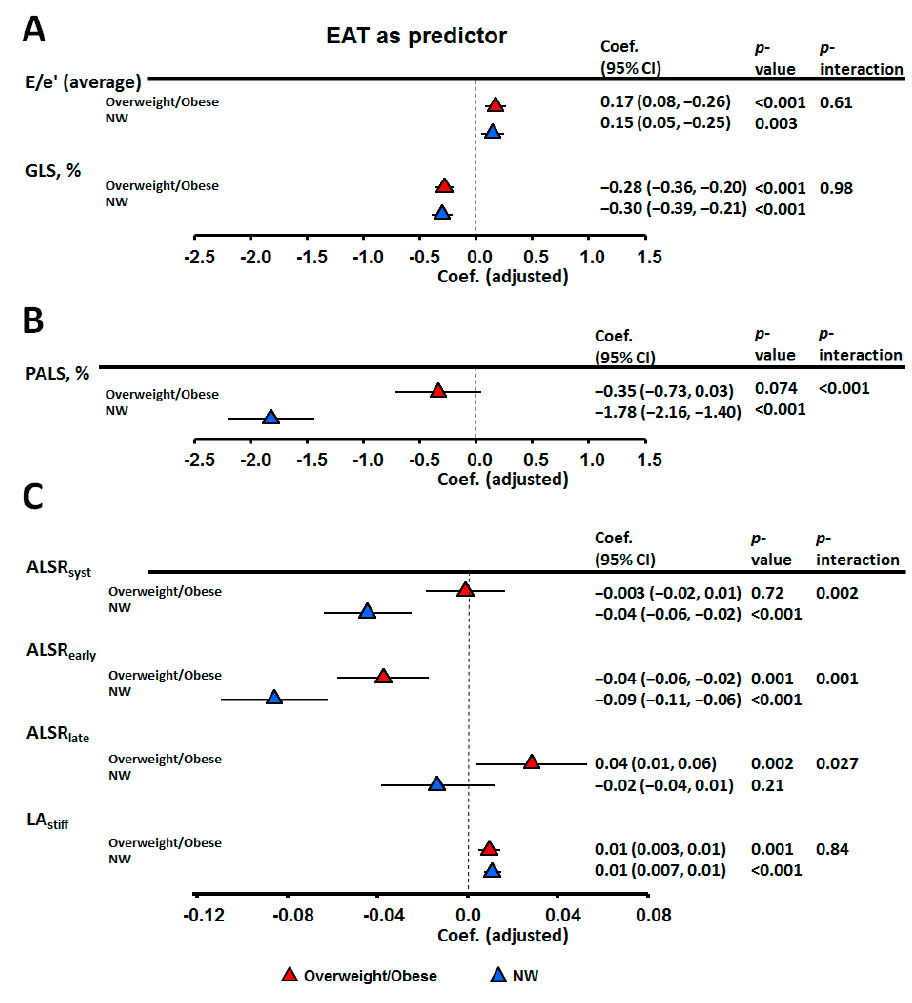
Figure 3. Multi-variate linear regression models exploring the relationships between epicardial adiposity thickness and various cardiac functional parameters, based on body mass index (BMI) strata. ( A ) LV indices adjusted for age, gender, BMI, systolic blood pressure (SBP), pulse rate, fasting glucose, estimated glomerular filtration rate (eGFR), triglyceride, high-density lipoprotein cholesterol (HDL-c) and left ventricle (LV) mass. ( B , C ) LA indices adjusted for age, gender, BMI, SBP, pulse rate, fasting glucose, eGFR, TG, HDL-c and left atrial maximum volume LAV (max).